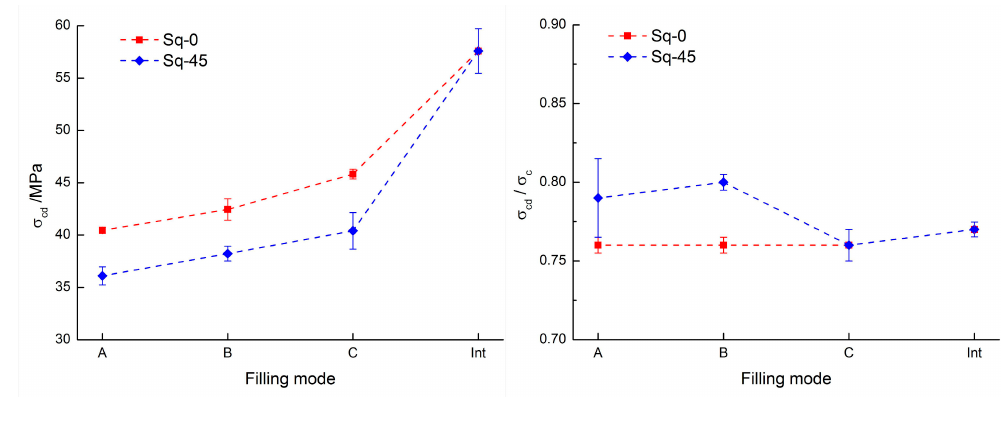
Figure 14. Effect of filling mode and hole angle on typical stress thresholds of sandstone specimens. Table 4. Crack stress thresholds and corresponding stress levels of the specimens under Figure 14c shows the crack damage stress σ cd and corresponding stress levels σ cd / σ c of each uniaxial group of specimens. Among them, the σ cd of pre-holed specimens with α = 0° and 45° are 40.45 MPa and 36.11 MPa, which are 29.75% and 37.29% lower than that of intact specimens, respectively. After filling, the change of σ cd with the filling mode is similar to that of UCS, which is basically linearly increasing with the change of Filling Mode from A to C, and the σ cd of specimens with α = 0° is